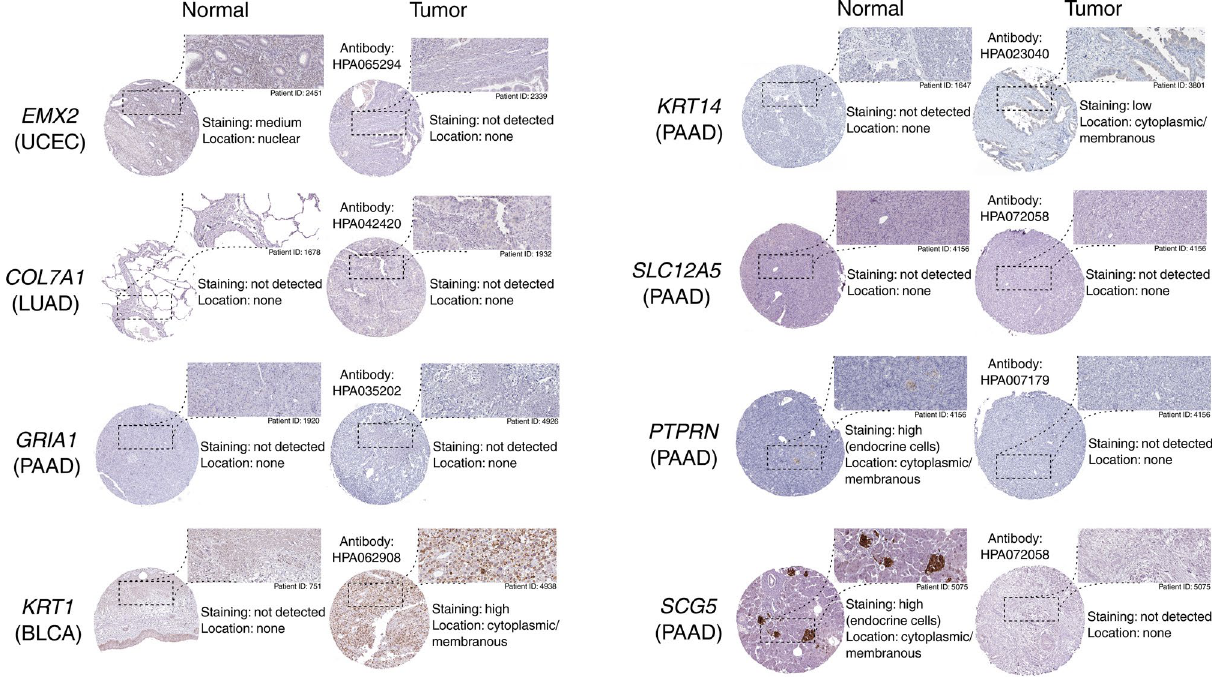
Figure 8. Representative immunostaining data for post-ROC genes from both normal and tumor tissues. For each gene, the cohort abbreviation for which it was identified throughout the study is given in